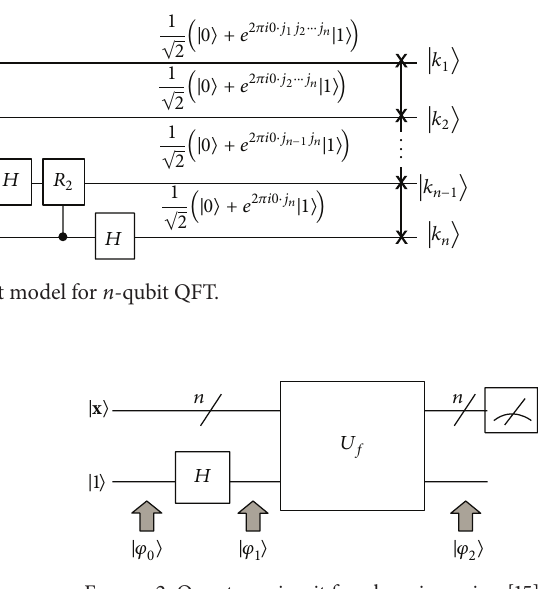
Figure 2: Quantum circuit for phase inversion